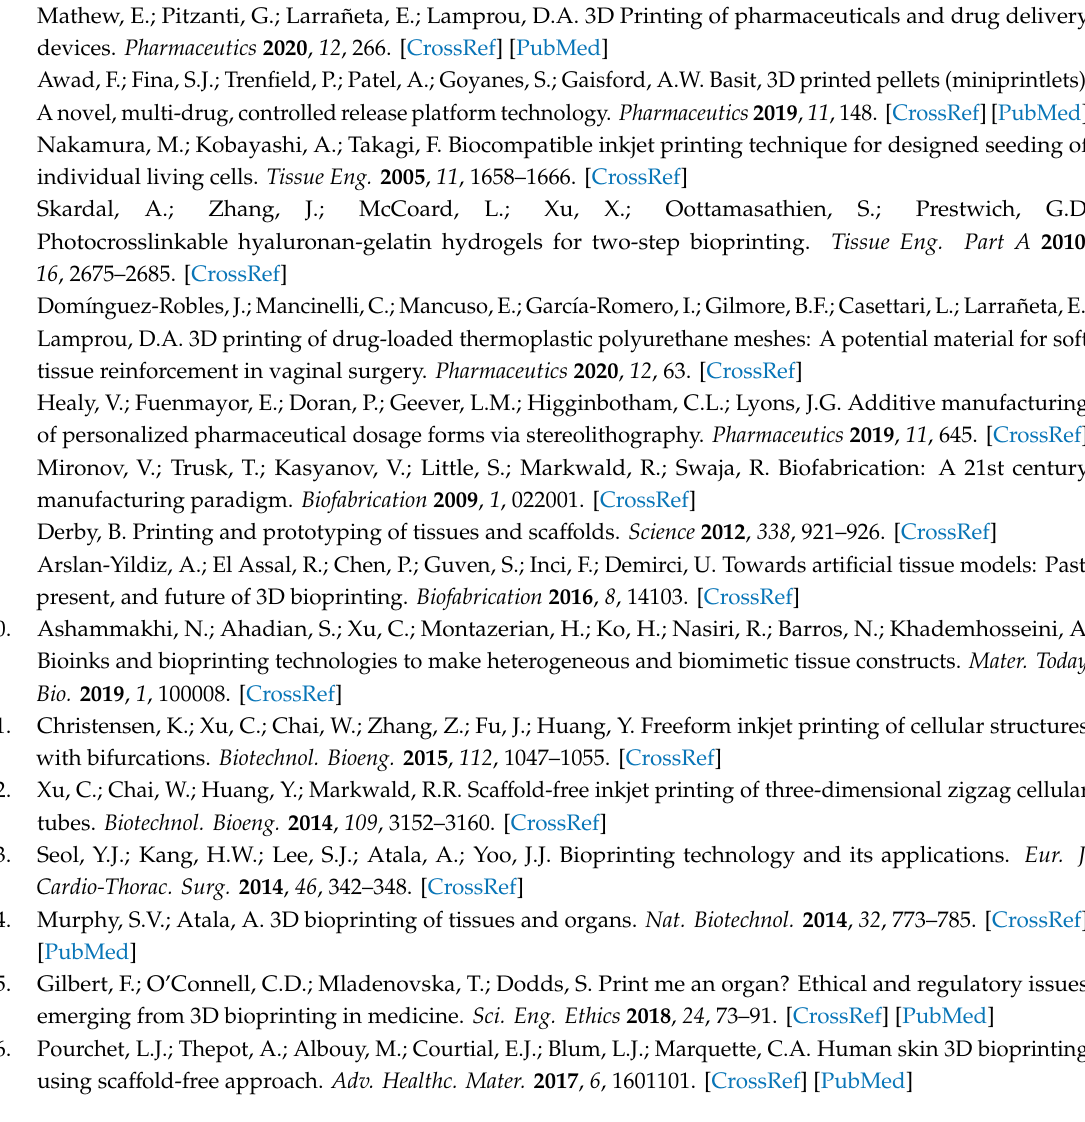
Figure S1: Maximum intensity projection images of bioprinted CH–GE–PEG cell-laden constructs throughout seven